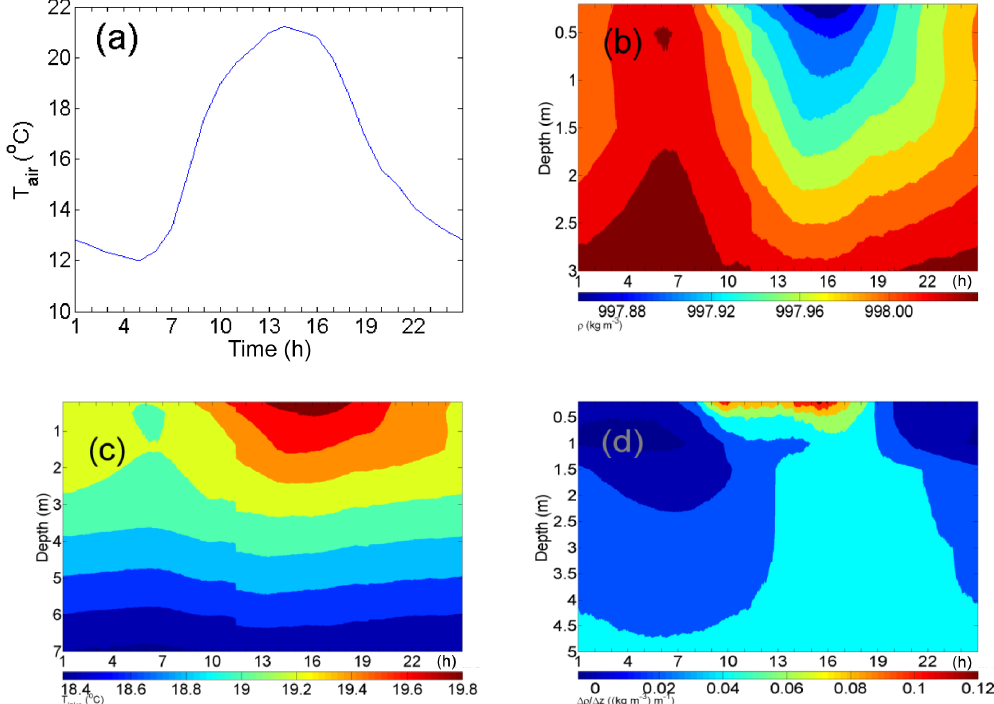
Figure 4. Diurnal variations in the observed air (2m above the ground) and lake temperatures during the period from 7 July to 5 November 2018 (panels a and c , respectively). Panels (b) and (d) depict the diurnal variations in water density (kgm − 3 ) and the vertical gradient of the water density ( ( kgm − 3 ) m − 1 ), respectively. The time on the abscissa corresponds to local standard time